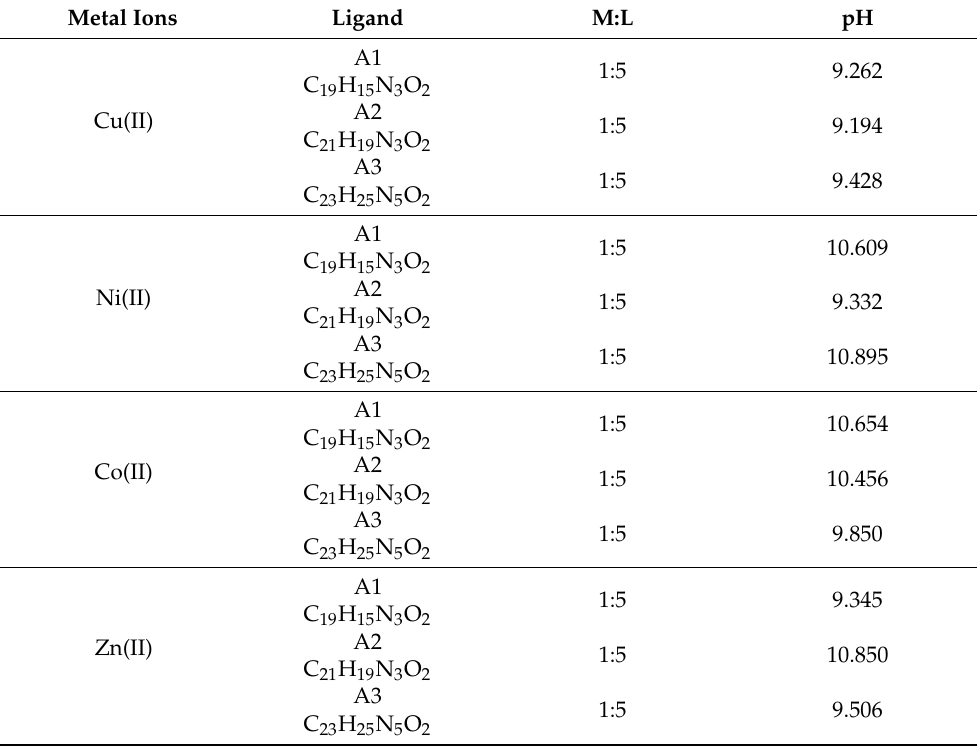
Table 3. The parameters of the membrane extraction